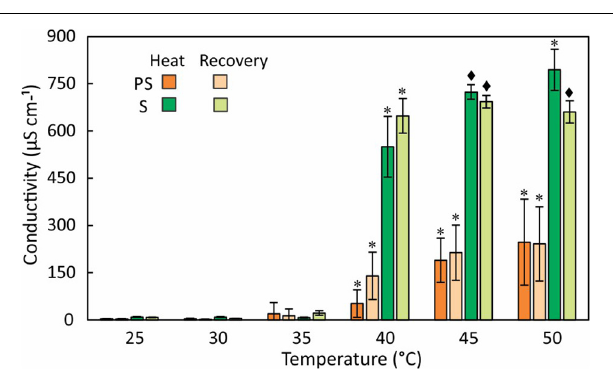
FIGURE 4 | Electrolyte leakage measured as conductivity of external water after 24 h at various temperatures and after a 24 h recovery period at RT. Differences in conductivity between heat treated and 25 ◦ C control are indicated by * ( P ≤ 0.05) and (cid:7) ( P ≤ 0.001); means ± SE, n = 6.